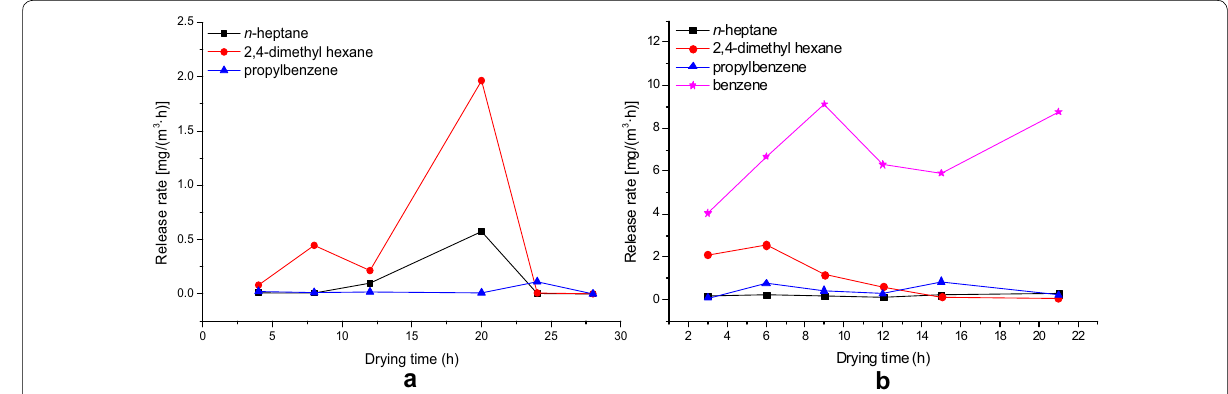
Fig. 4 Variations of release rate of alkane and benzene during a conventional drying, and b high-temperature drying